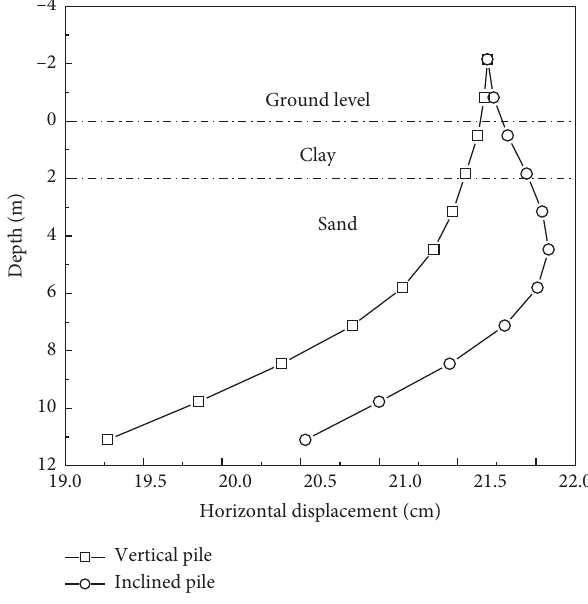
Figure 18: Horizontal displacement of piles.